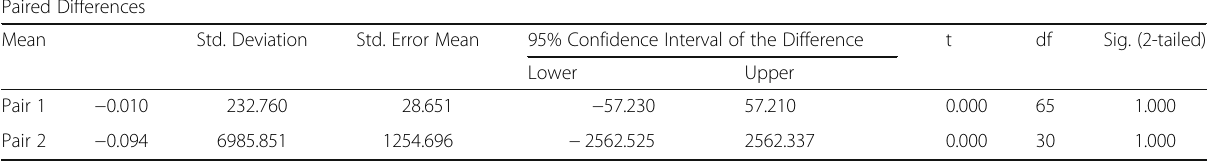
Pair 1-peak hour flow; Pair 2-day